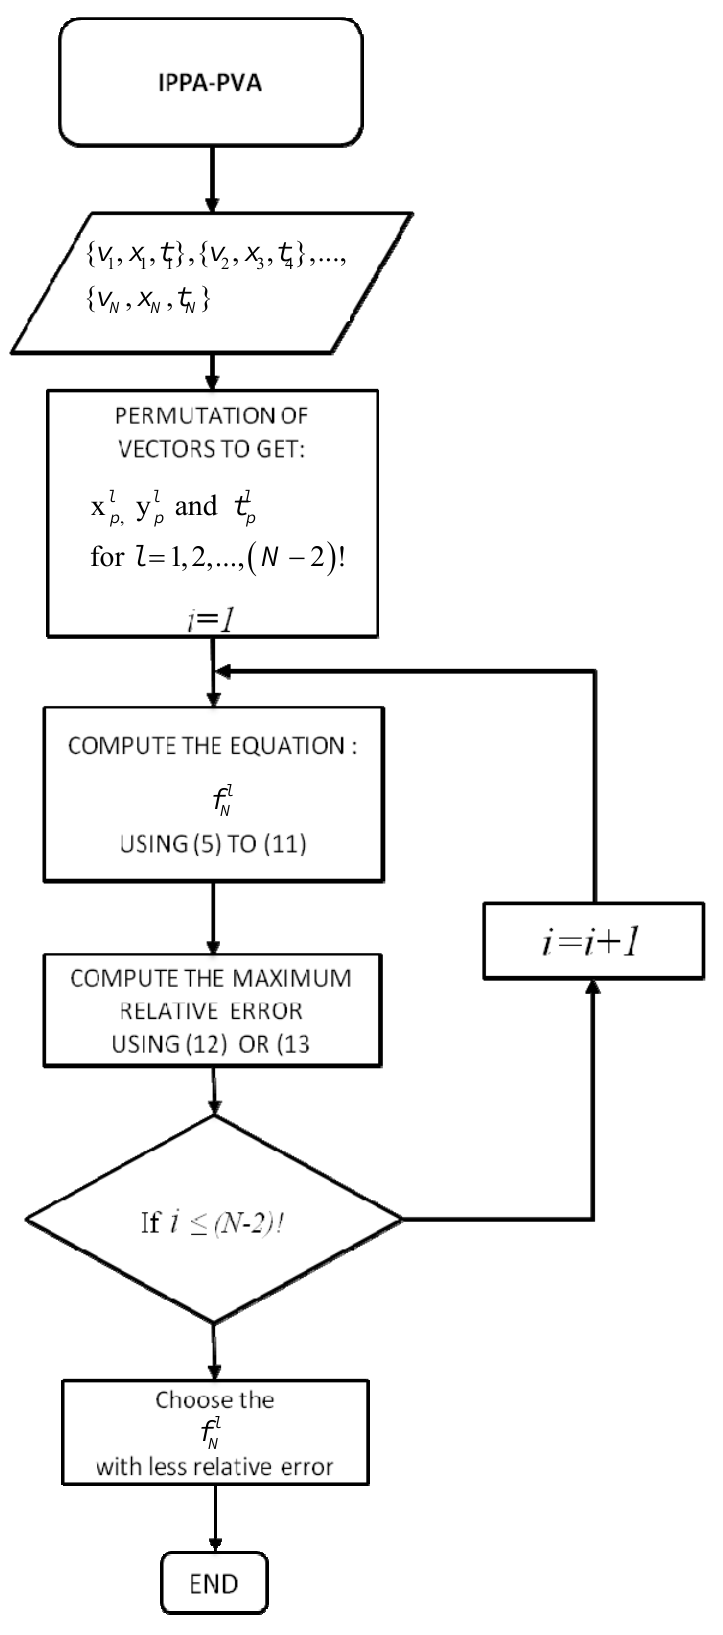
Figure 6. Flow chart of the PVA